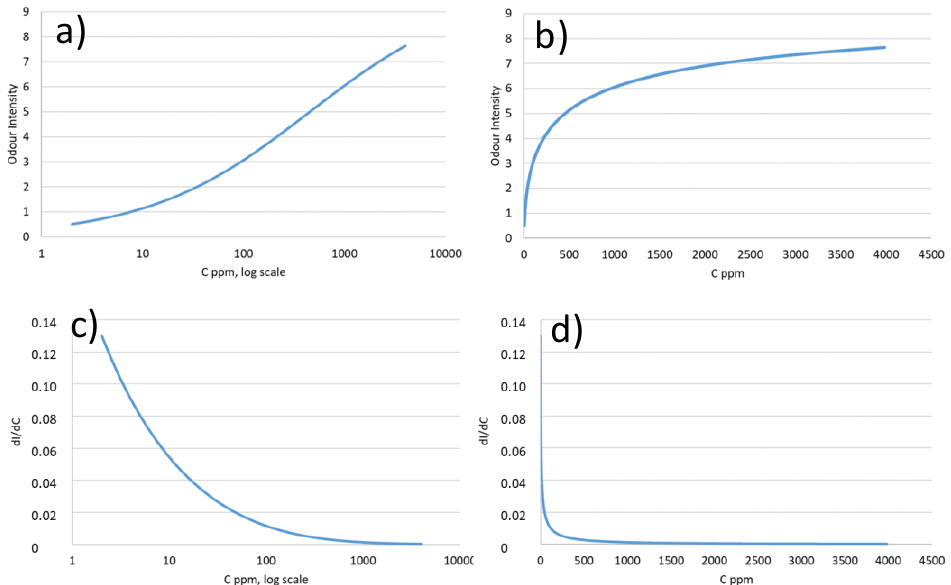
Figure 6. A typical psychophysical plot obtained by the function proposed by Chastrette et al. [71], with I max = 10, C ip = 450 mg/L (concentration at the inflection point), n = 0.54 and threshold = 2 mg/L and its first derivative. ( a , b ) represent the concentration vs. odour intensity in standard logarithmic and lineal concentration scales, respectively; and ( c , d ) the concentration vs. the first derivative of the functions in standard logarithmic and lineal concentration scales,